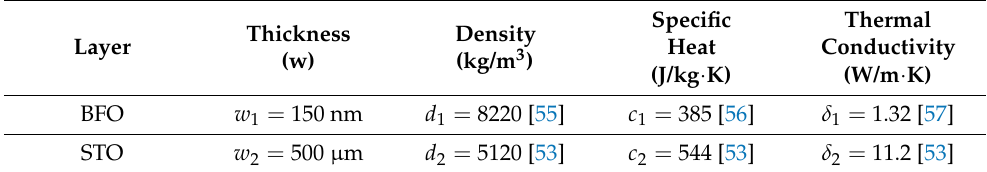
Table 1. The physical quantities that are used to calculate the thermal time constant, using Equation (2).